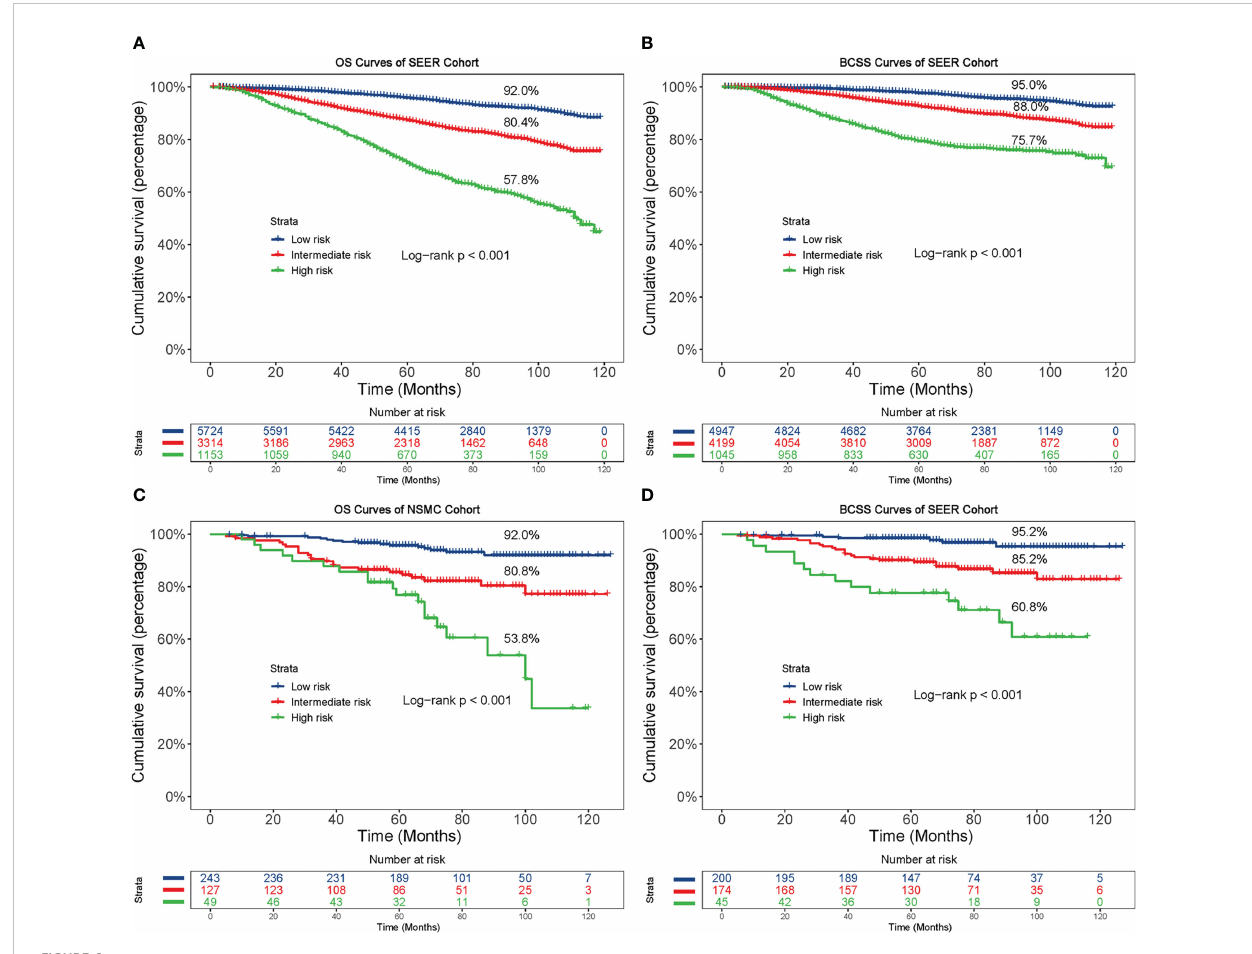
FIGURE 6 Kaplan-Meier curves based on the risk model. Based on the risk model, patients were divided into low-, intermediate- and high-risk groups, and then the OS and BCSS curves were plotted in the SEER cohort (A, B) and NSMC cohort (C, D) , respectively. OS, overall survival; BCSS, breast cancer- speci fi c survival.